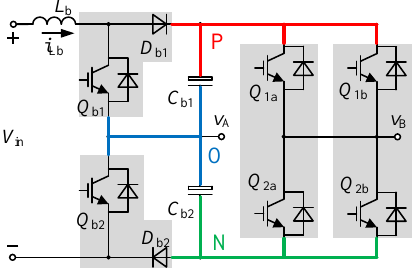
Figure 1. Novel auxiliary power supply for urban rail transit train.